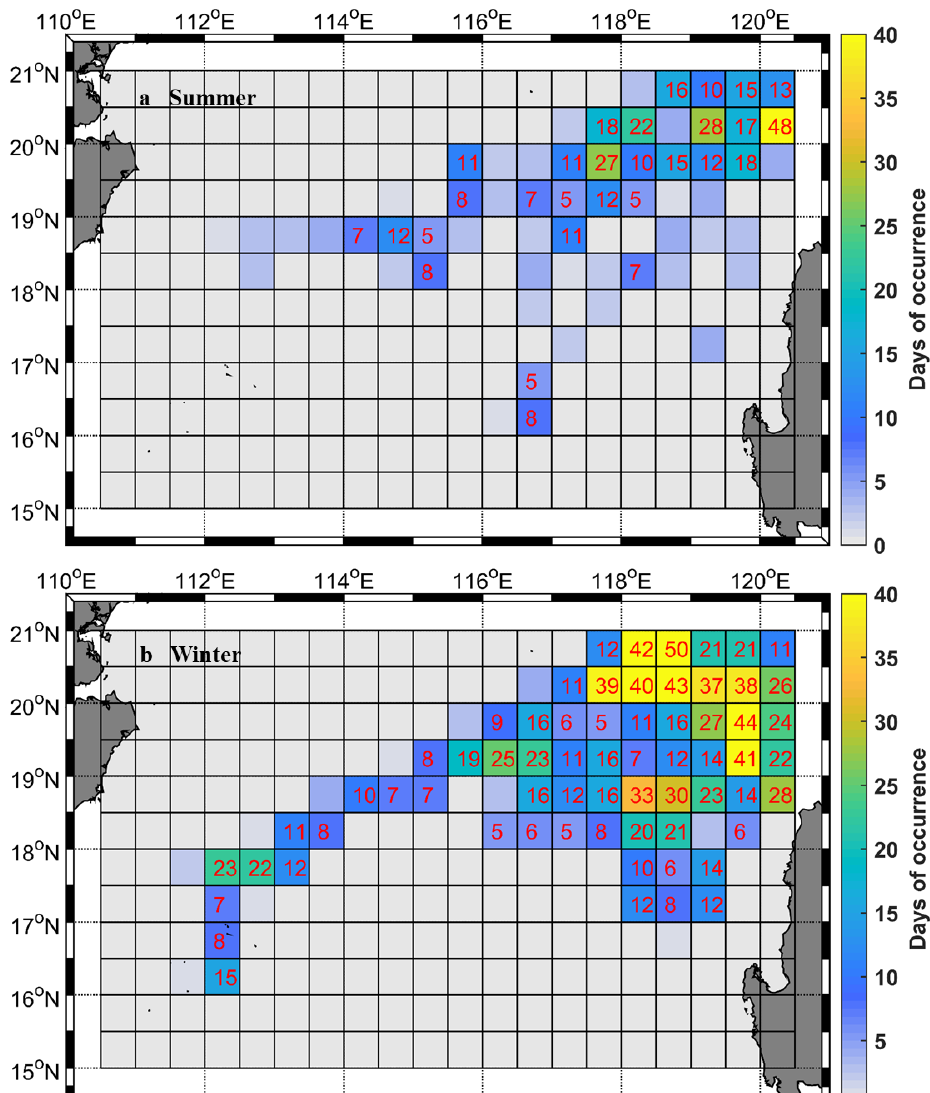
Figure 12. The spatial patterns of eddy occurrence (existence days ≥ 5) in the NSCS from 1993 to 2017. ( a ) Summer (June – August); ( b ) Winter (December – February).